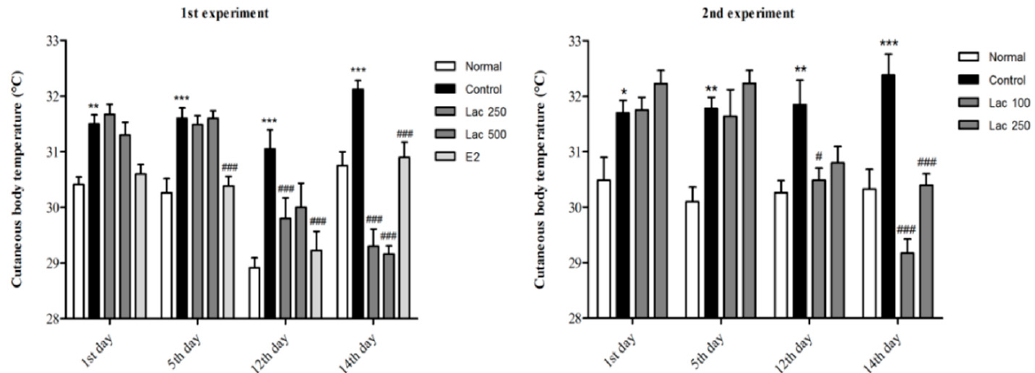
Figure 4. Oral lactate administration induced a reduction in cutaneous body temperature in rats with ovariectomy surgery (OVX) and stress. Control groups exhibited a gradual increase in cutaneous temperature; however, the estradiol and all lactate groups showed a notable decline in the cutaneous body temperature, especially in the last day of treatment. Values are presented as mean ± SEM. *, ** and *** show differences between the normal and control groups, while # and ### show significant differences between the control group and treatment groups. # p < 0.05 and ### p < 0.001. The p -value of the test was <0.001 by one-way ANOVA, followed by a post hoc LSD test.